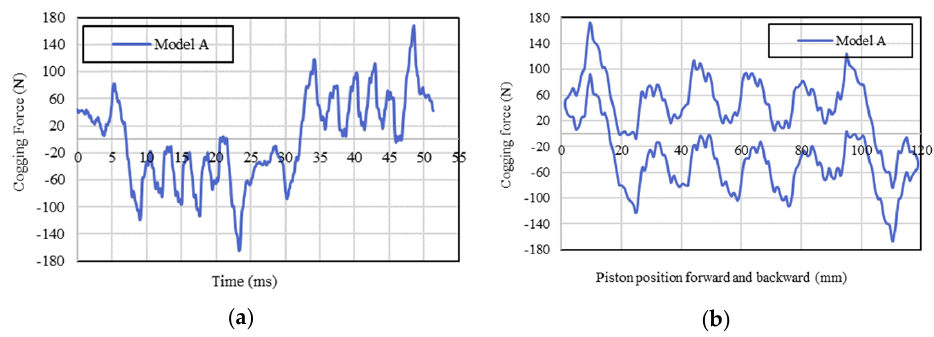
Figure 14. Cogging force of Model ‘A’ generator versus: ( a ) time and ( b ) piston position.